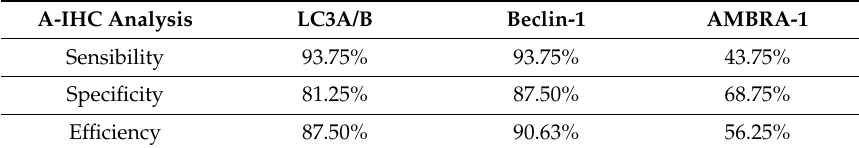
Table 2. Performance of autophagy-related proteins by immunohistochemistry in advanced tubular gastric adenocarcinomas.